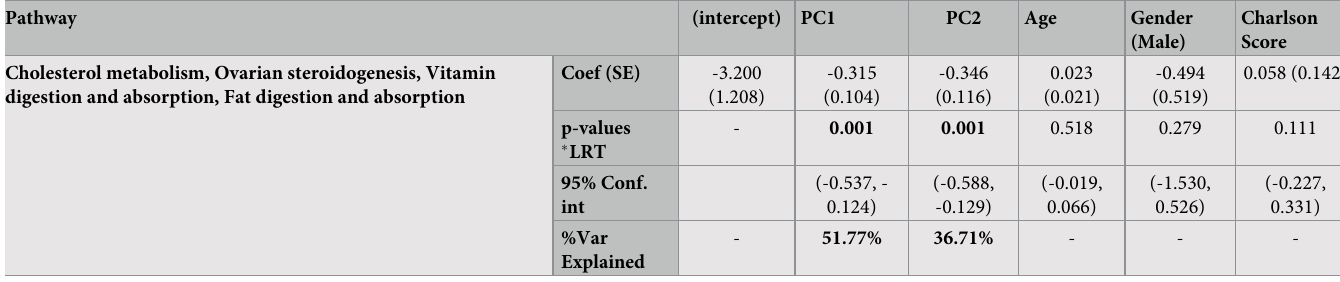
Summary of multivariate logistic regression models with COVID-19 status as the outcome and the principal components used to summarize the enriched pathways associated with COVID-19 status as the predictors. The models are also adjusted for the clinical covariates age, sex and Charlson comorbidity score. P-values for significance are determined via the likelihood ratio test